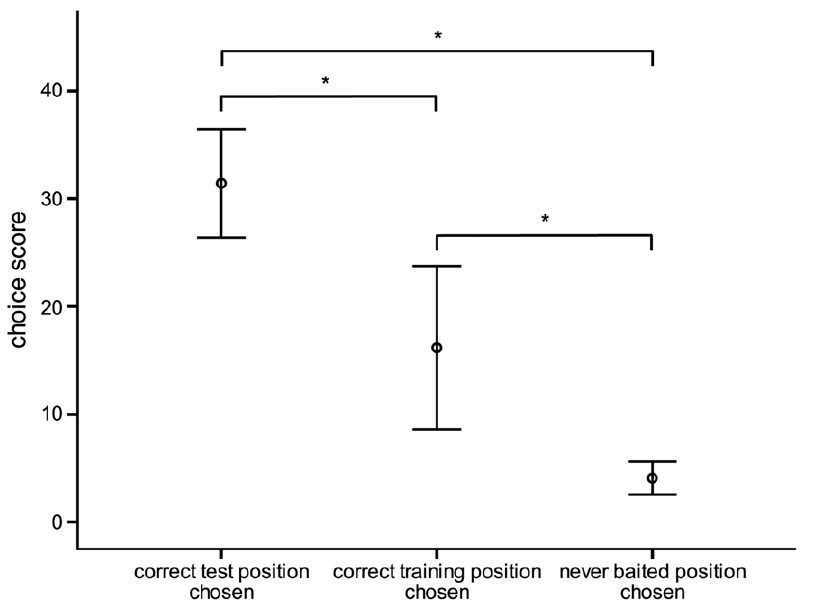
Figure 3. Choice scores. Choice scores calculated from all ten test trials (N=7, means 6 SD). In the test phase, quails could choose between three alternatives. First, one of the actually accessible cups, second, a cup that was baited in the training sessions, third, a cup that was never baited before. For calculation of choice scores and statistics see text.